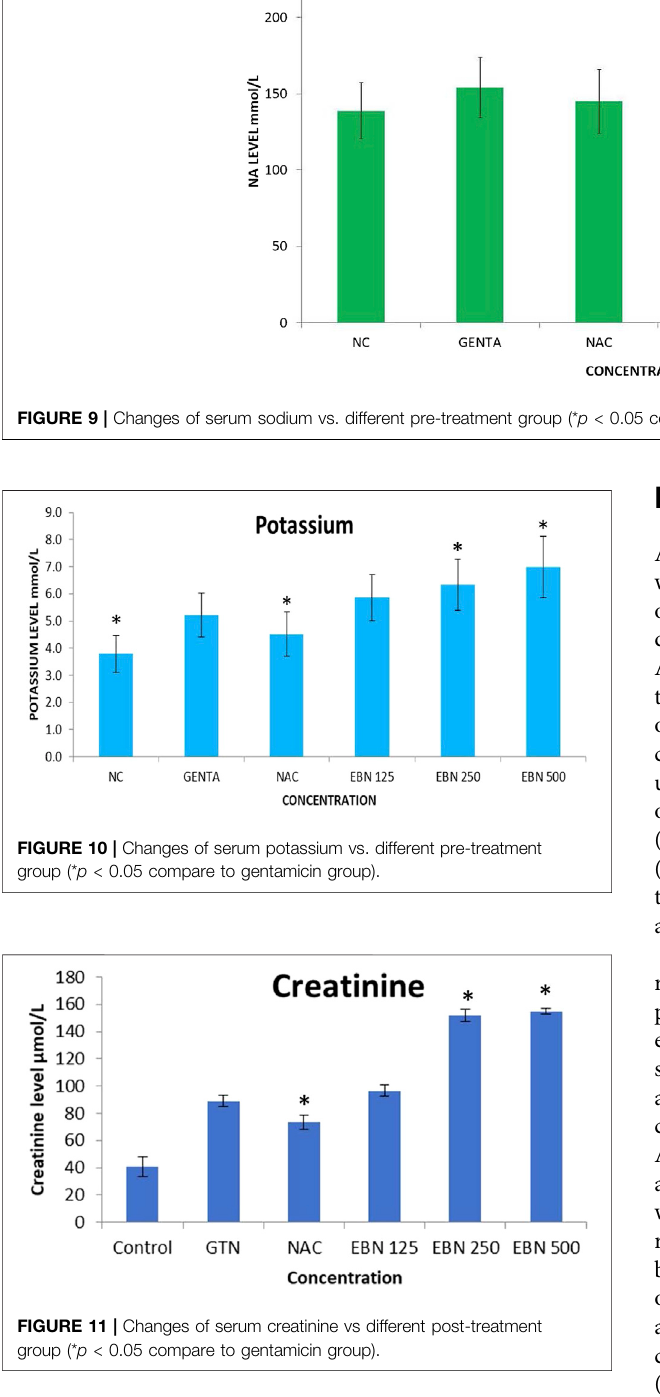
Frontiers in Pharmacology |